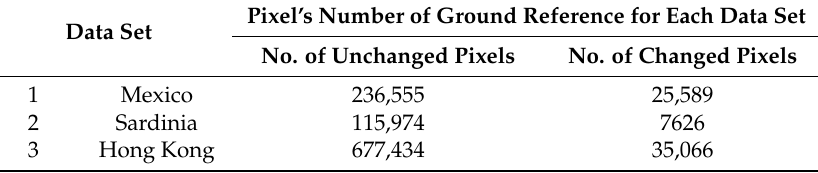
Table 2. Details of ground reference pixels for each